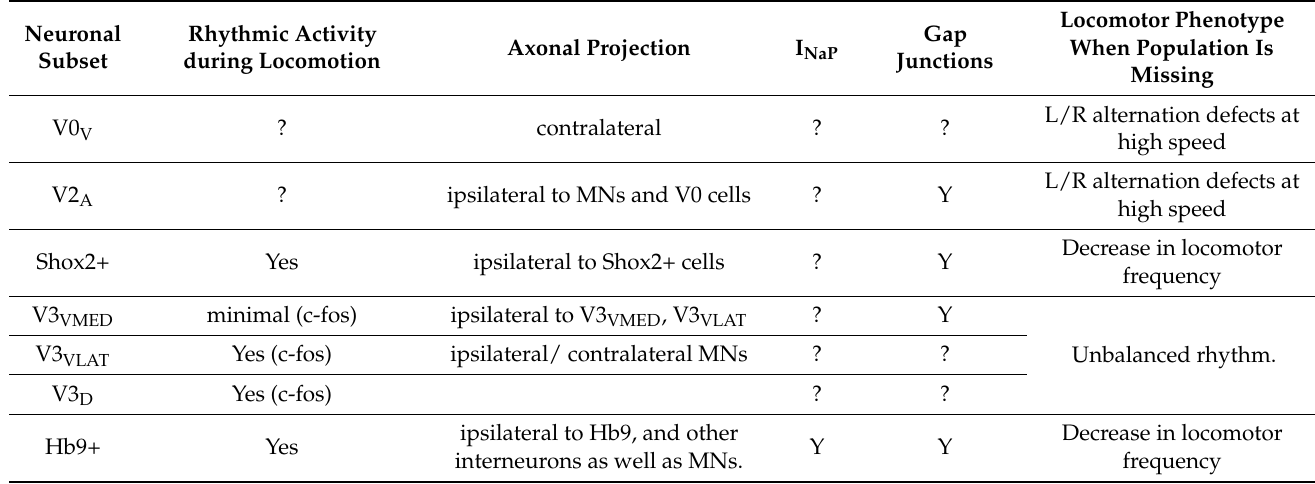
Axonal Projection